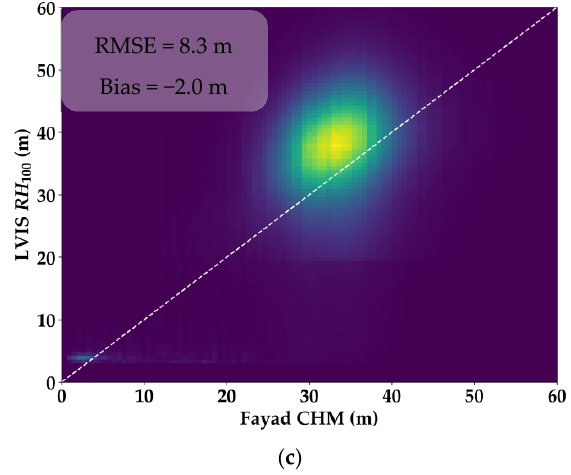
( c ) Figure 9. RH 100 estimates of waveforms with sensitivity ≥ 98% from GEDI’s coverage (C RH 100 , a ) and full-power lasers (FP RH 100 , b ), as well as those from LVIS (LVIS RH 100 , c ) as a function of Fayad CHM. Table 2. Mean (M) and standard deviation (SD) in meters of the estimated RH 100 for waveforms with sensitivity ≥ 98%. (C) and (FP) correspond to the RH 100 values from GEDI’s coverage and full-power lasers, respectively. (LVIS) corresponds to the RH 100 values from LVIS. Fayad CHM (m)